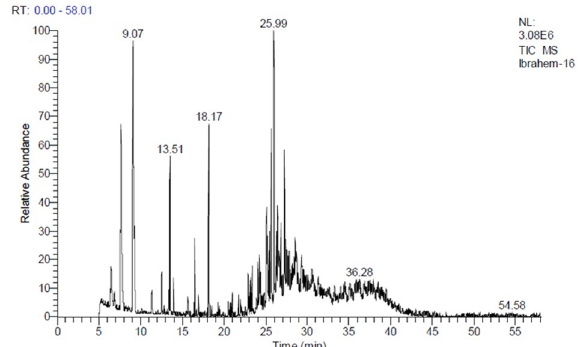
Figure 4. GC/MS analysis of Thymus vulgaris L.